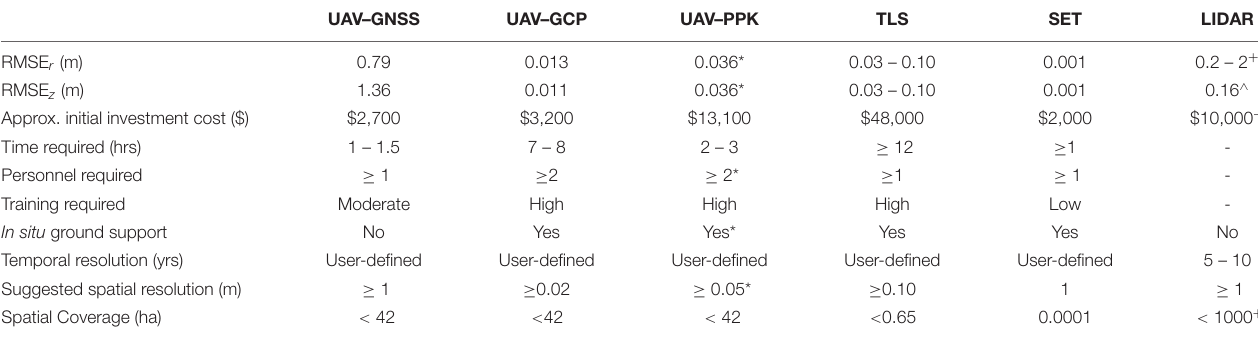
TABLE 4 | Comparison of different topography data collection methods, including UAV with onboard uncorrected GNSS (UAV–GNSS), UAV georeferenced using 50 surveyed GCPs (UAV–GCP), UAV equipped with PPK (UAV–PPK), terrestrial laser scanning (TLS), surface elevation table (SET), and airborne